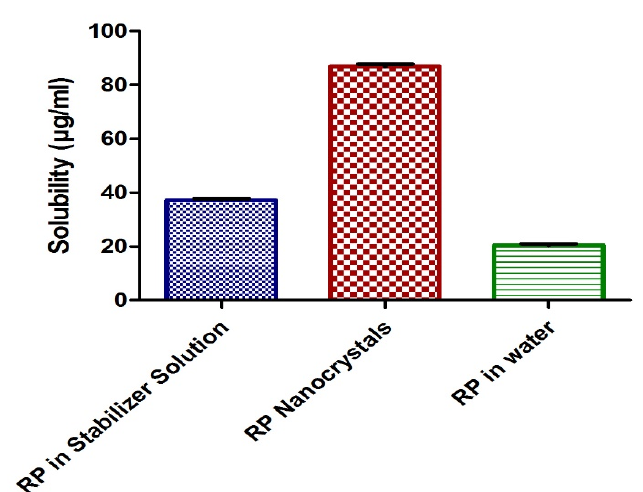
Figure 5. Solubility studies of Rp nanocrystals (Rp ‐ Nc) and raw Rp.